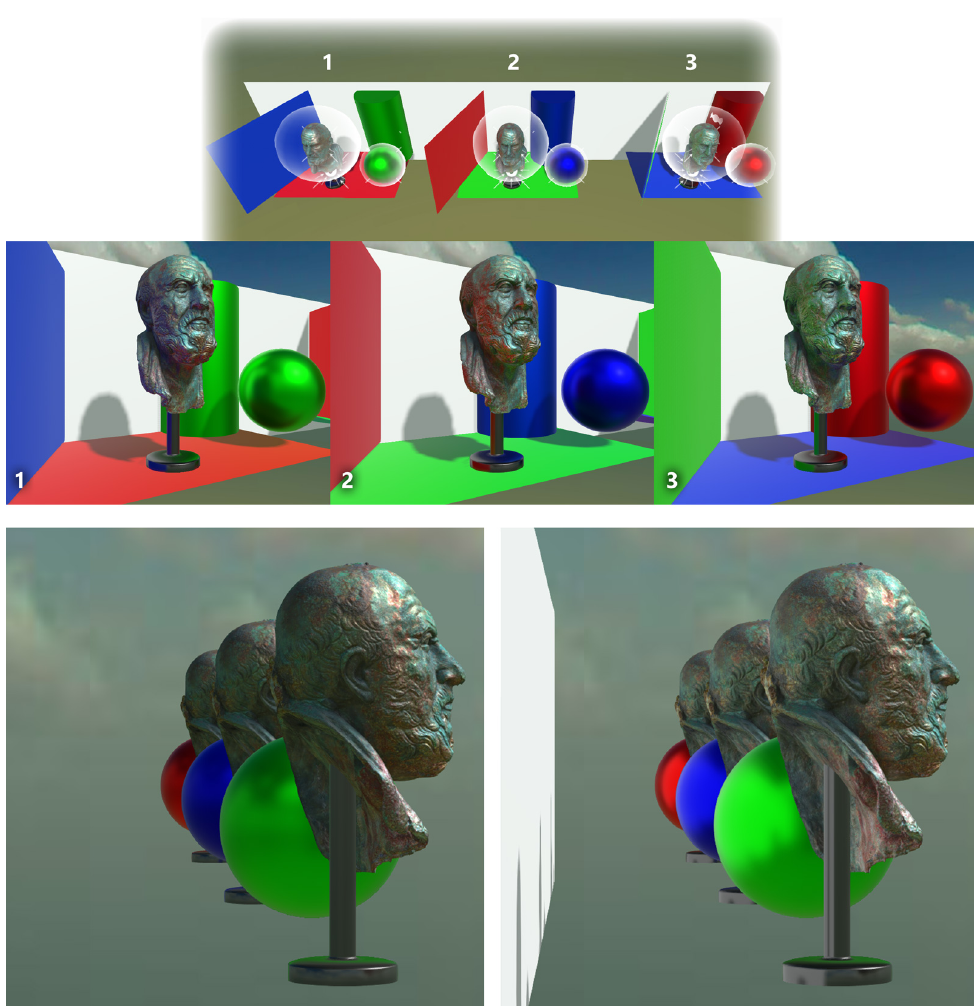
Figure 19. A different setup to assess multiple light-probes on 3 instances of the 3D